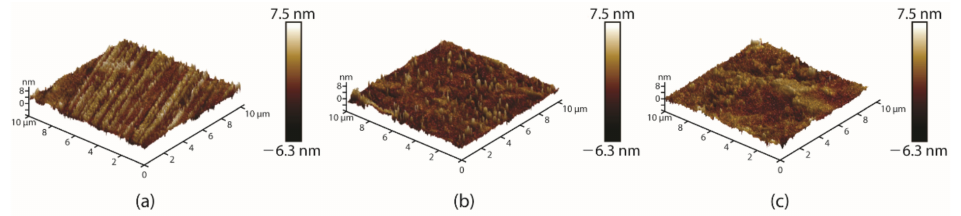
Figure 8. AFM test of Ti cold-spray samples after grinding and polishing: ( a ) 2p, ( b ) 8p, and ( c ) 14p. The nano-indentation test was performed on the Ti cold spray and HiPIMS TiN thin film to obtain Young’s modulus, which was then used to calculate the residual stress. For the cold-spray Ti, Young’s modulus measured by the indentation was within the normal range for Ti 2p, 8p, and 14p and varied between 106 GPa and 114.5 GPa. The hardness of Ti cold spray samples ranged from 2.4 GPa to 2.8 GPa (Table 2). The Ti cold spray